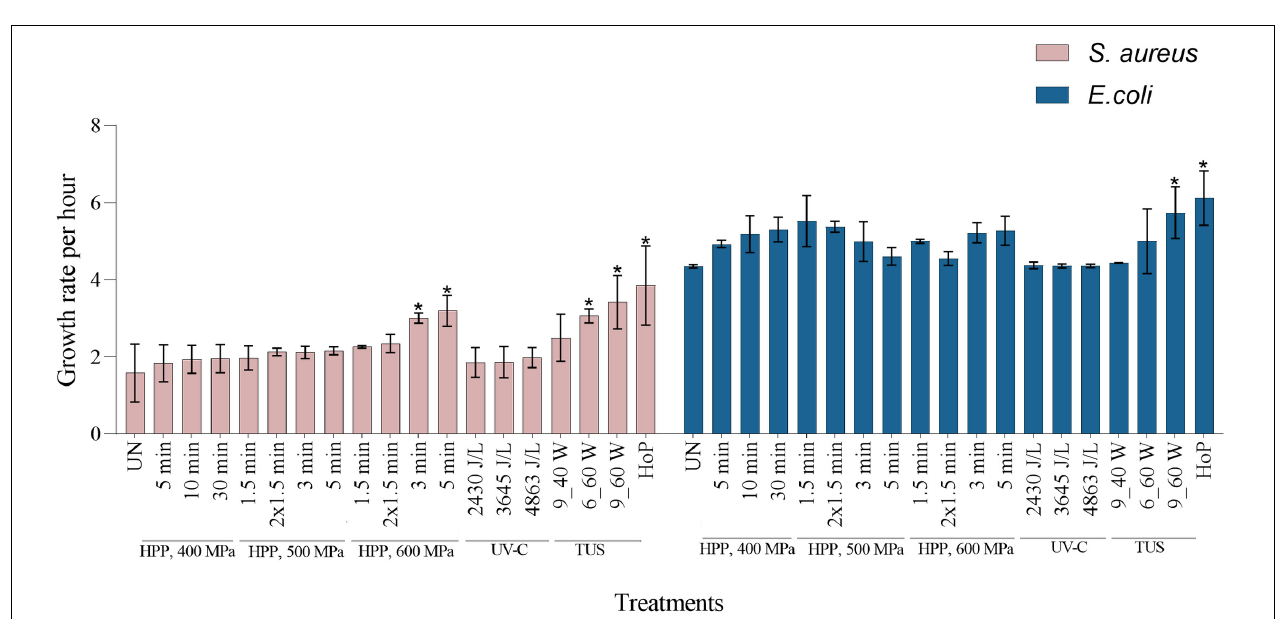
FIGURE 5 | BSSL retention after HPP, UV-C, TUS, and HoP, based on iBAQ intensities and a lipase activity assay. Untreated values were set at 100% (dotted line). The results are presented as mean ± standard deviation of two independent experiments and all analyses were performed in technical duplicate.*Indicates significant differences to untreated samples ( p < 0.05).